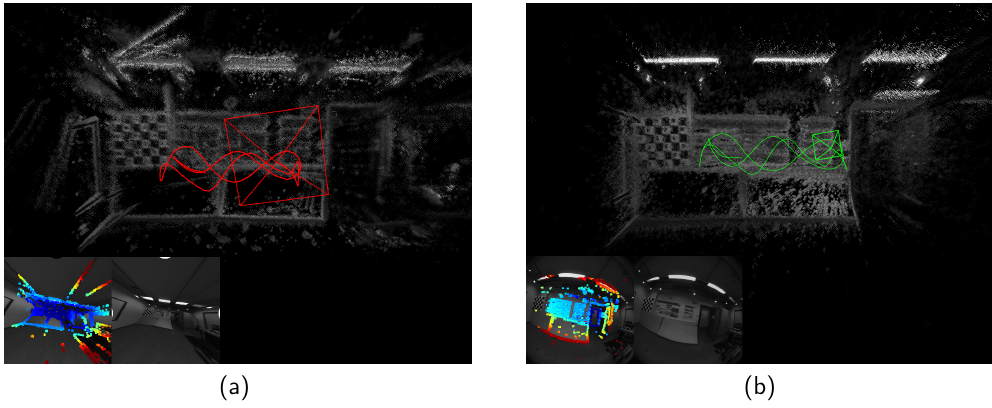
Figure 4. Visual odometry on Room 1. ( a ) DSO, which initializes VO with a direct approach. Notice the top left part of the recovered 3D geometry is incorrect. ( b ) Our method that initializes visual odometry with a feature-based approach. The 3D reconstruction is more